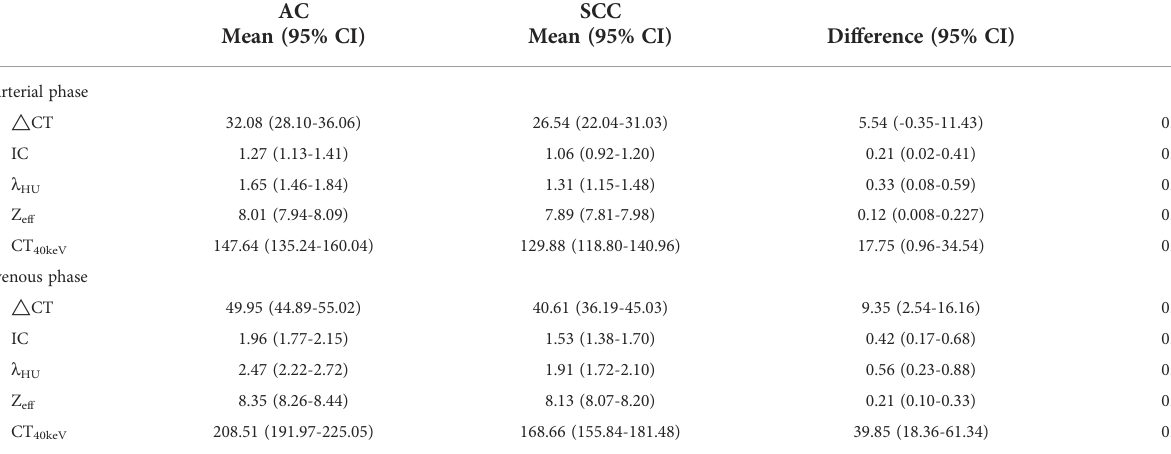
TABLE 2 Dual-energy CT parameters in the AC and SCC groups in AP and